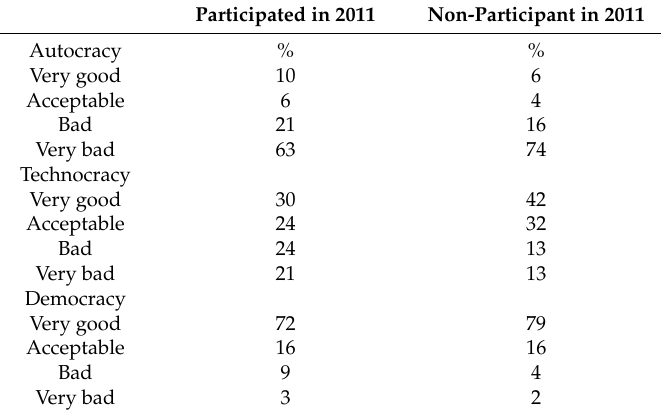
Table 3. Views on different political systems, 20–29 year olds.